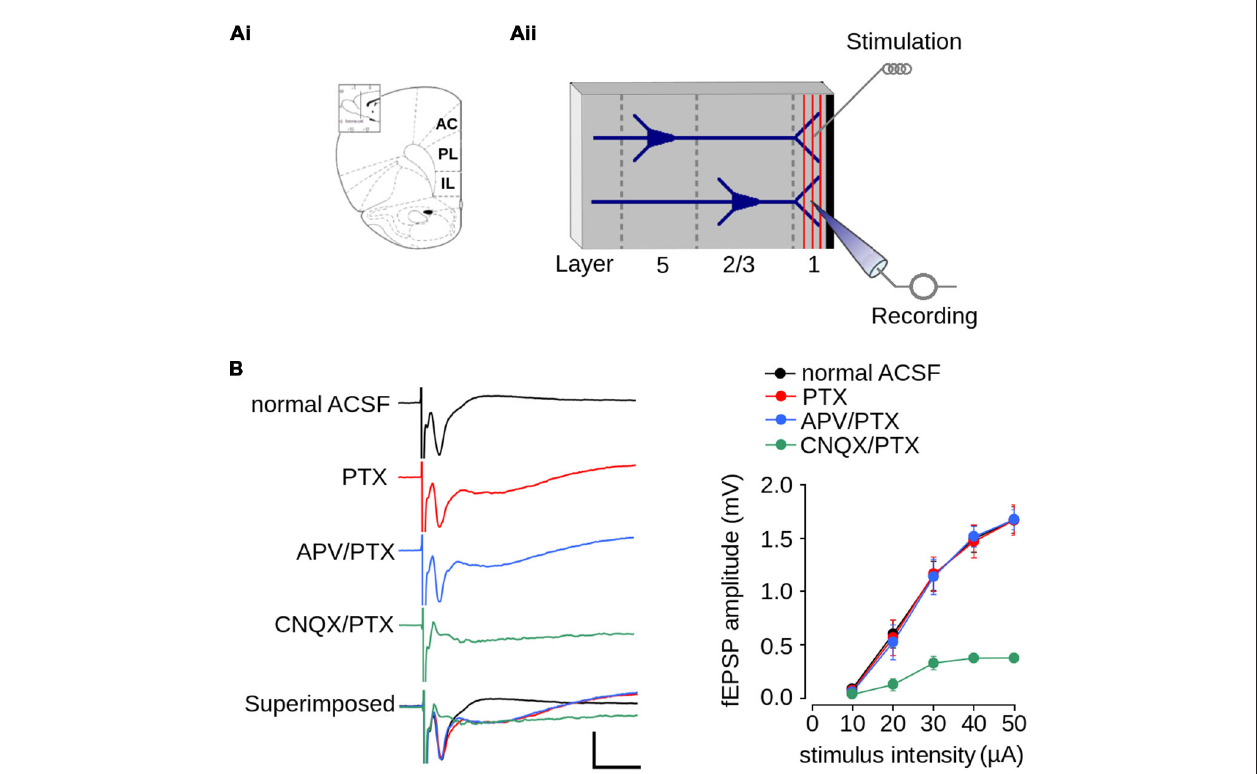
FIGURE 2 | Excitatory field post-synaptic potential recorded in layer 1 of mPFC. (Ai) Schematic diagram of the rat mPFC (from Paxinos and Watson, 1998; AC, cingulate cortex; PL, prelimbic cortex; IL, infralimbic cortex); (Aii) Schematic diagram of the location of the recording and stimulating electrodes in layer 1 of mPFC. (B) Pharmacologically isolated components of the fEPSPs recorded in layer 1. Left panel, representative traces of the isolated fEPSPs evoked at the same stimulus intensity. From top to bottom: response in normal ACSF; in ACSF containing 1 µ M picrotoxin (PTX); in ACSF containing 1 µ M PTX and 50 µ M APV; in ACSF devoid Mg 2 + containing 5 µ M CNQX and 1 µ M PTX; and superimposed traces (scale bar: 1 mV; 10 ms). Right panel: summarized input-output curves plotting the average fEPSP amplitude at different stimulus intensities in standard ACSF or in the presence of the indicated drugs in the perfusion bath. Data are expressed as mean ± SEM ( n = 4 animals, 17-23